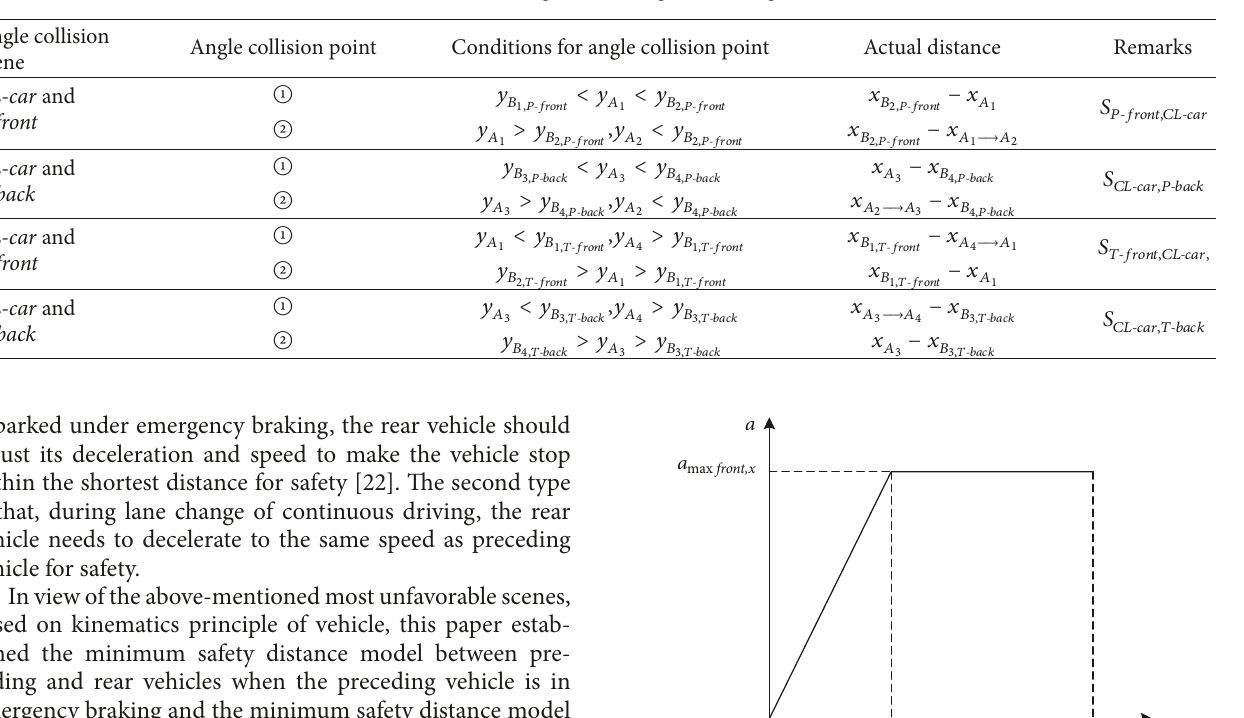
Table 2: Actual distance during the two-stage lane change in four scenes.